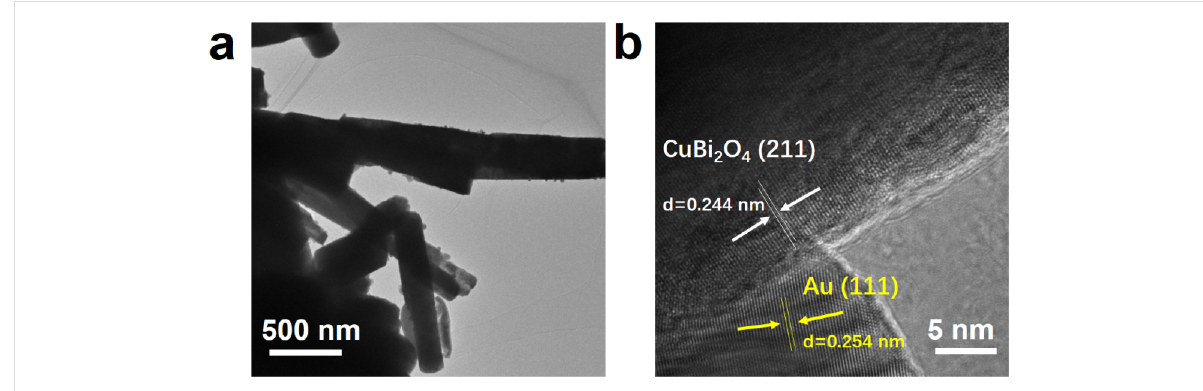
Figure 4: (a) TEM and (b) HRTEM images of the 2.5 wt % Au/CBO composite.